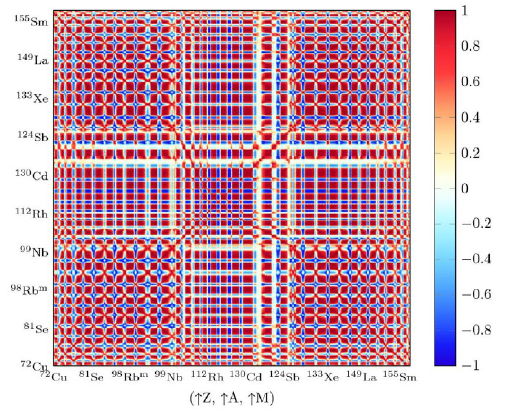
Fig. 7. Independent yield correlation matrix from CEA